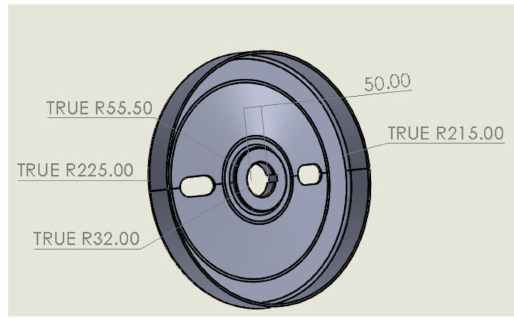
Figure A6. Threshing disk (Dimensions in mm).